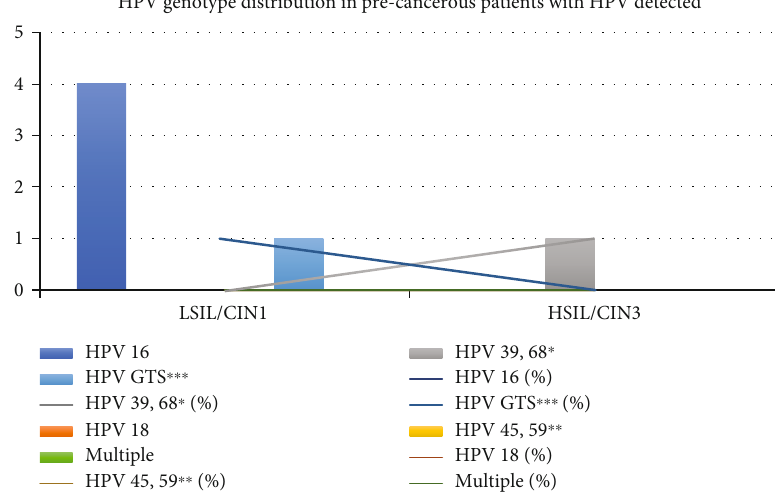
Figure 5: HPV genotype distribution in precancerous patients with HPV